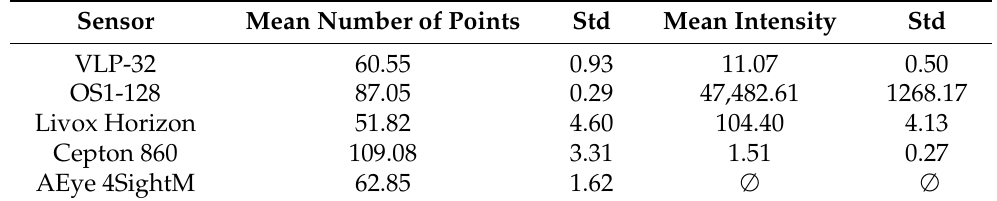
Table 4. Mean values and standard deviations of number of points on the target and associated intensities in clear